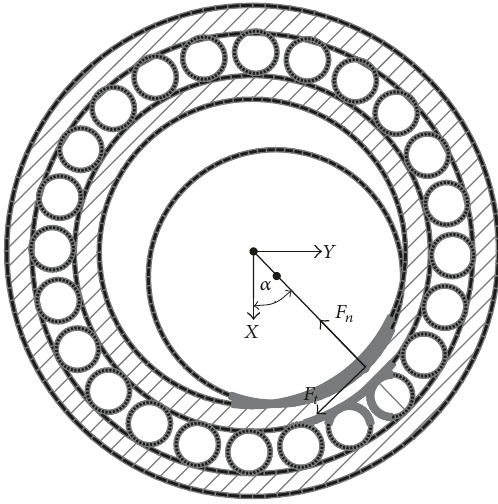
Figure 1: Sketch of auxiliary bearing and contact